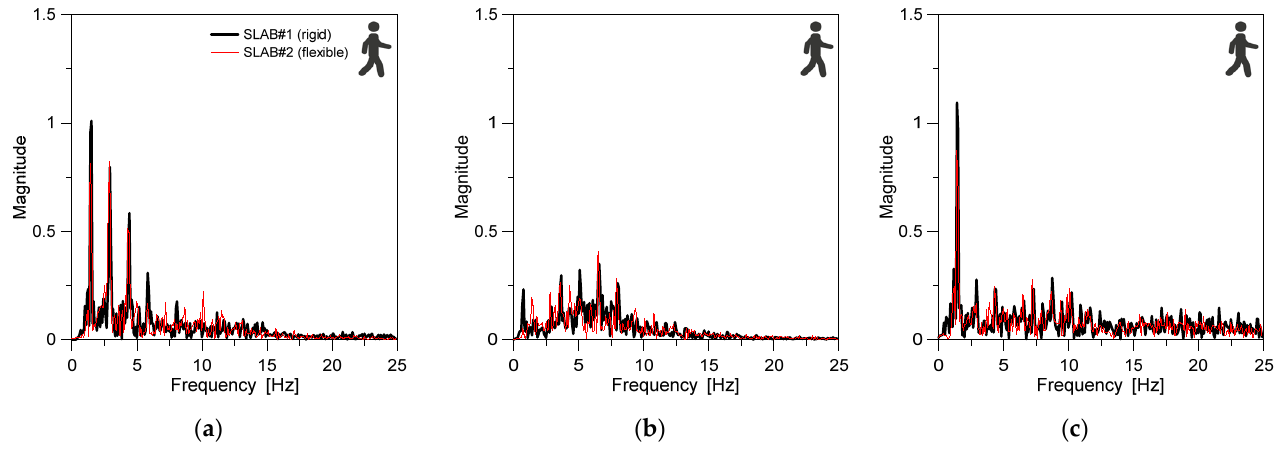
Figure 7. Analysis of experimental body CoM acceleration records (W0 signals) in terms of fast transform magnitude, with evidence of ( a ) vertical, ( b ) transversal, and ( c ) longitudinal components.